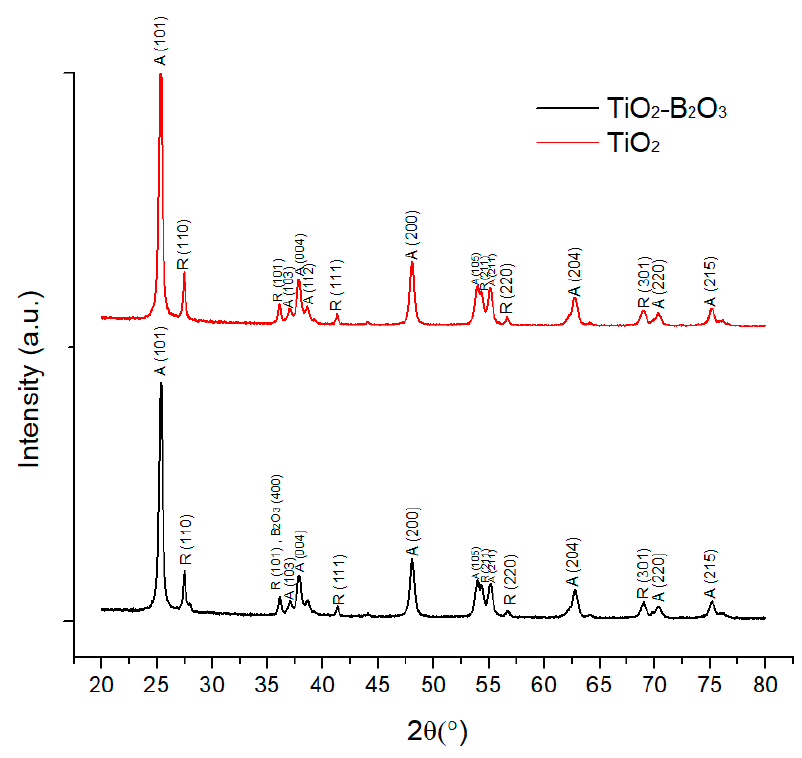
Figure 7. X-ray diffraction pattern of TiO 2 (P25) and TiO 2 -B 2 O 3 .